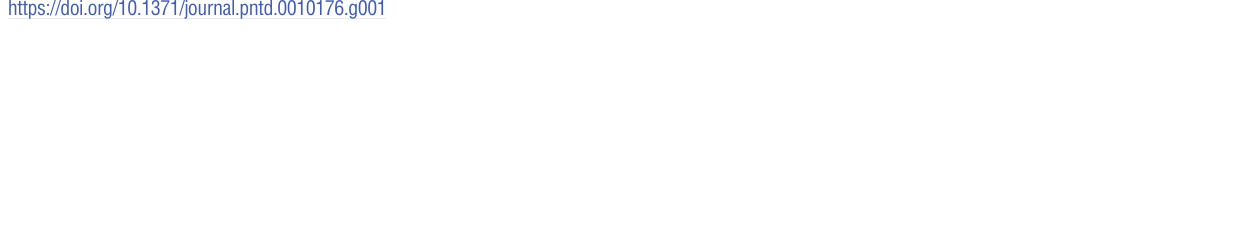
PLOS NeglectedTropical Diseases | https://doi.org/10.1371/journal.pntd.0010176 February 15, 2022 8 /